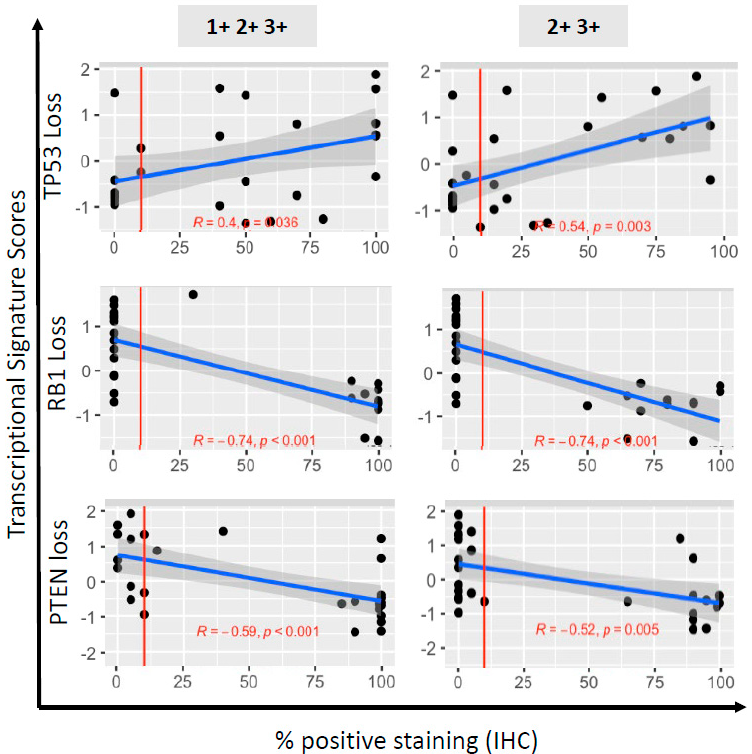
Figure 3. Correlation of immunohistochemistry (IHC)-based determination of TSP loss with func- tional downstream tumor suppressor pathway loss, in 28 PDX models of human prostate cancer. Shown are scatterplots of marker transcriptional scores (TP53, RB1 or PTEN pathway loss) against IHC % labeling indices. The 3 loss scores (rows) are regressed on percentage positive by IHC either 1+2+3+ (left column) or 2+3+ (right column). The red vertical line at 10% corresponds to the threshold for determining abnormal or normal based on IHC staining. The blue line is the ordinary least squares regression fit. The grey shaded region around each line is a 95% confidence interval set for the fit. The correlation (R) and significance of correlation ( p -value for testing if correlation is 0) are included in each plot in red